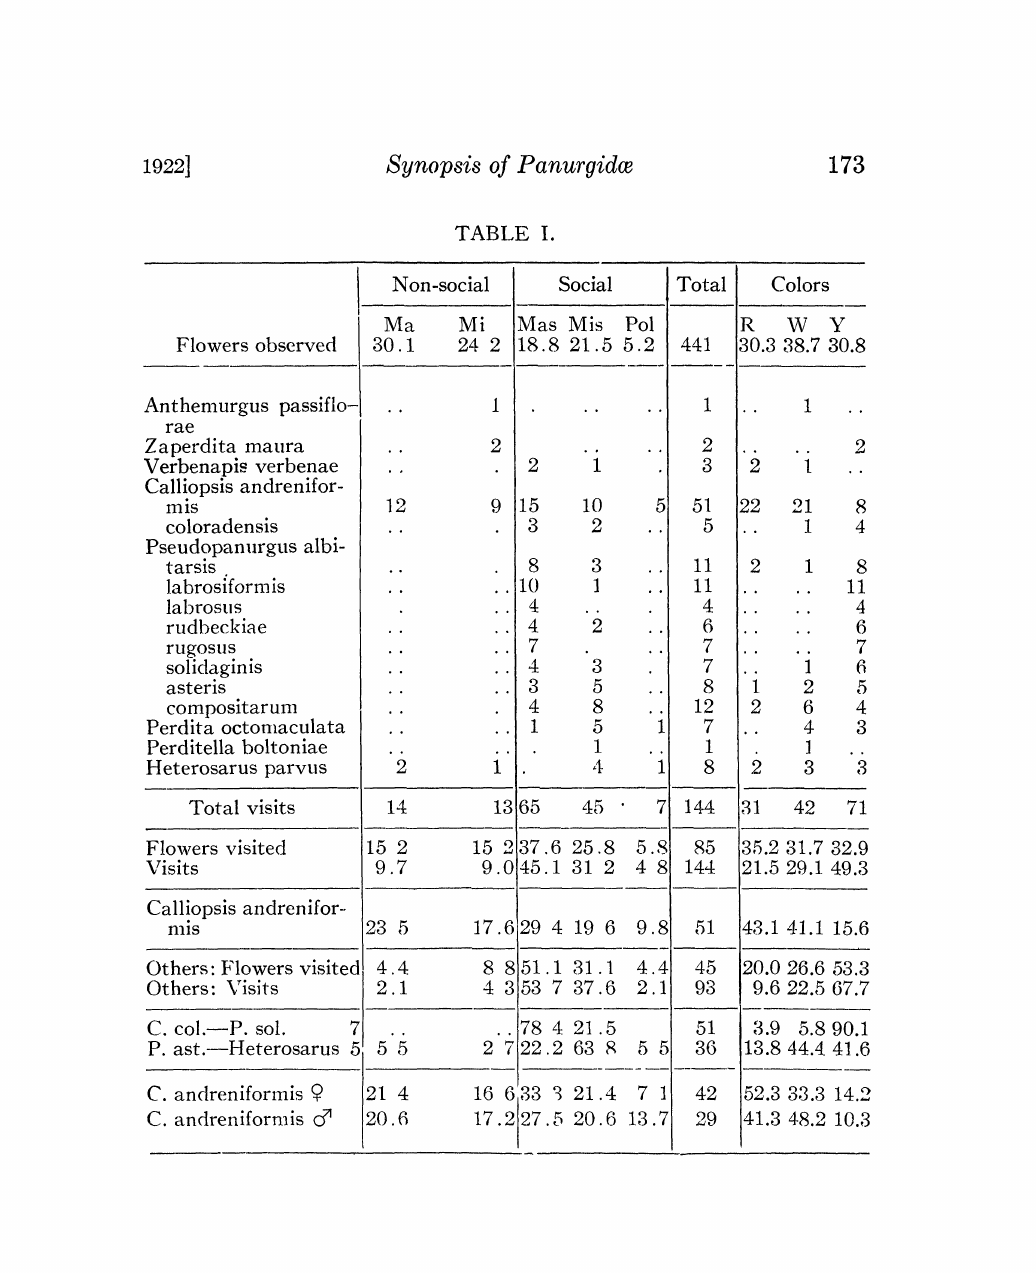
Flowers observed Anthemurgus passiflo- rae Zaperdita maura Verbenapis verbenae Calliopsis andrenifor- mis coloradensis Pseudopanurgus albi- tarsis labros{formis labrosus rudbeckiae rugosus solidaginis asteris compositarum Perdita octomaculata Perditella boltoniae Heterosarus parvus Total visits Flowers visited